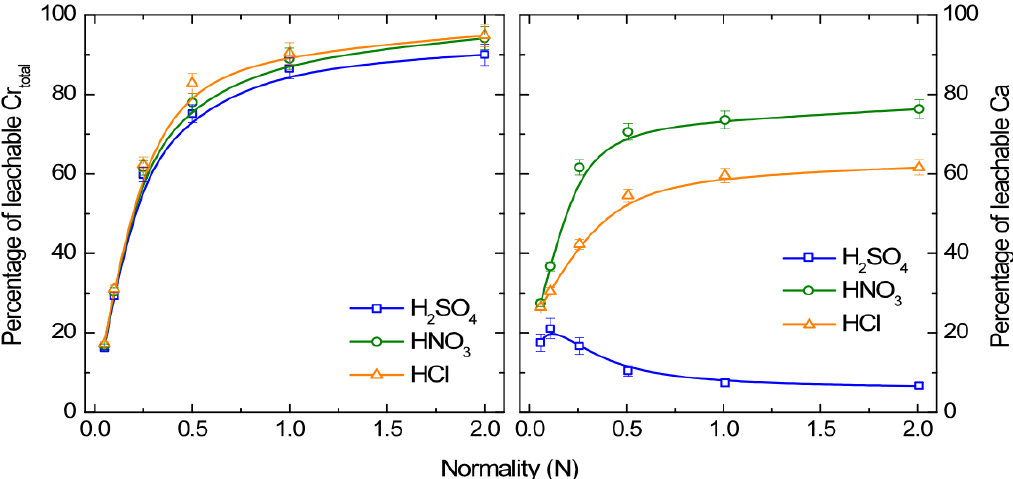
Figure 4. Cr total and Ca extraction from the thermally treated tannery sludge at 700 °C, using different common acids, applied in different (initial) concentrations.